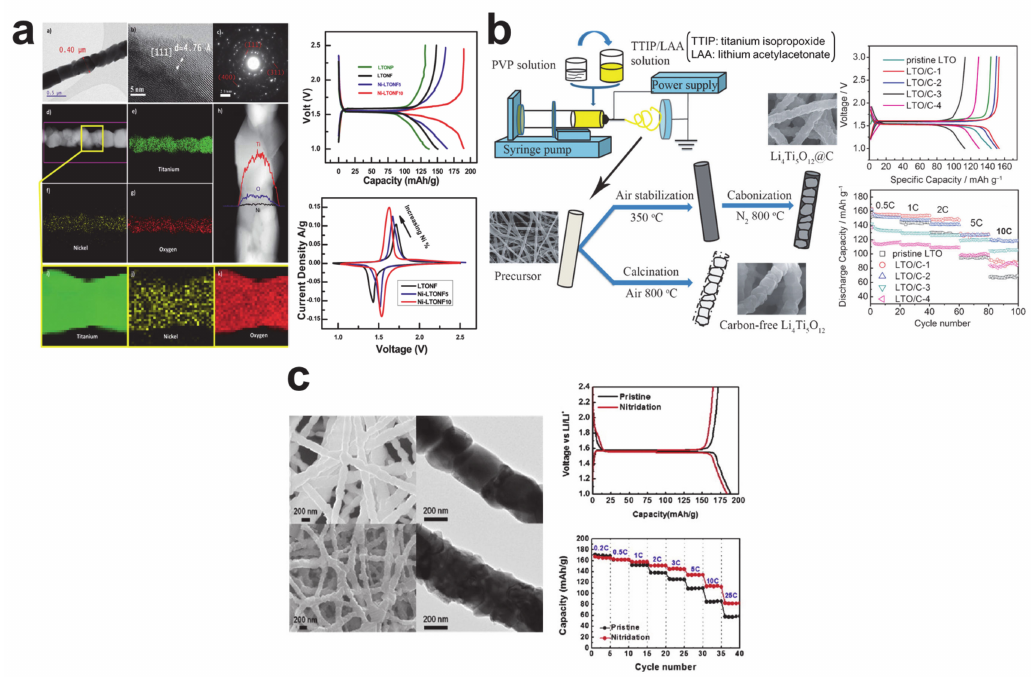
Figure8. Li 4 Ti 5 O 12 nanofiberanode materialsand theirelectrochemical performances. ( a )Nickel-doped Li 4 Ti 5 O 12 nanofiber (reprinted with permission from [71]; copyright 2016 Royal Society of